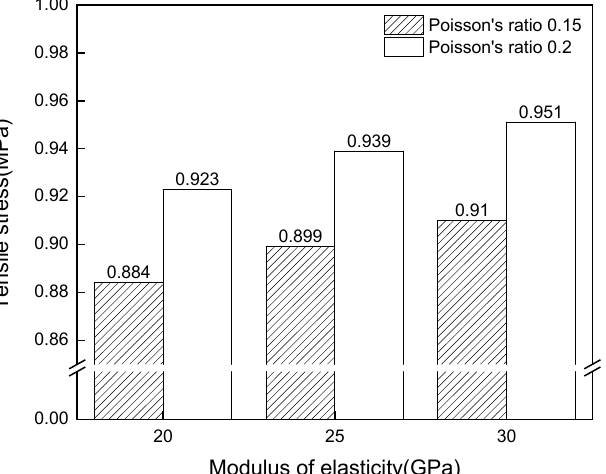
Figure 5. Histogram of tensile stress corresponding to different Poisson’s ratios and compressive elastic moduli of pea gravel concrete. Table 5. Tensile stress corresponding to different Poisson’s ratios and compressive elastic moduli of hemihydrate gypsum self-leveling mortar, UHPC.